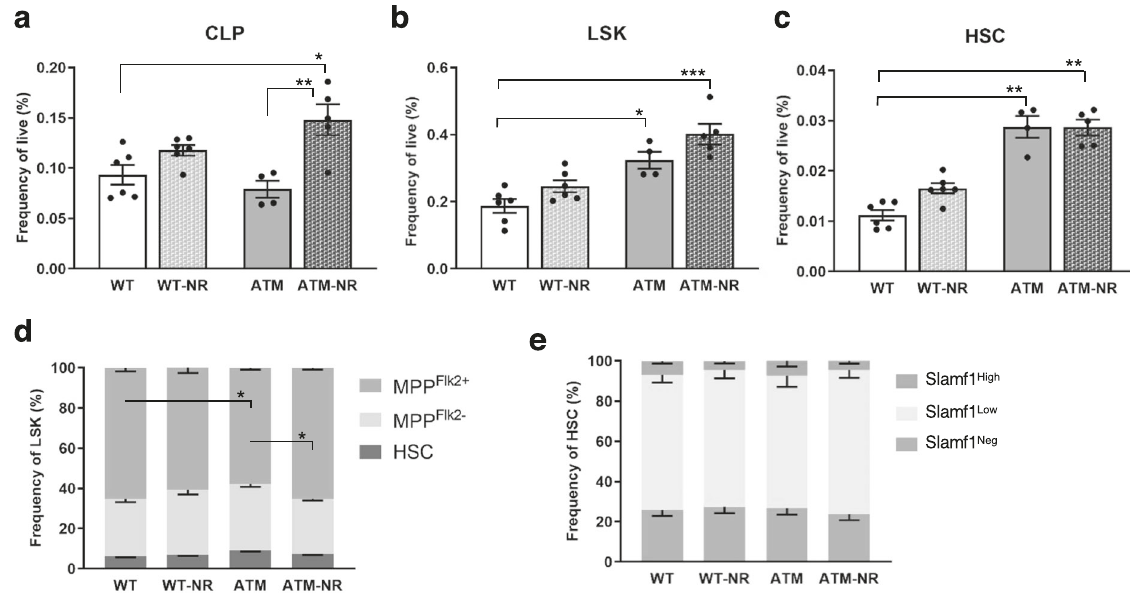
Fig. 1 NR treatment increases lymphoid-progenitor cell frequencies in Atm − / − bone marrow. a – c Frequency analysis of early progenitor compartments in NR-treated (NR) or untreated bone marrow from Atm + / + (WT) or Atm − / − (ATM) mice (2 – 3 months). CLP common lymphoid progenitors (Lin − IL-7R α + Flk2 + ), LSK lineage − Sca1 + c-Kit + , HSC Lin − c-Kit + Sca1 − CD34 − Flk2 − . d Composition of the LSK compartment. e Frequencies of lineage-biased subsets of HSCs de fi ned by Slamf1(CD150) expression. Data are represented as mean ± SEM. n : 4 – 6. Kruskal – Wallis test for a – c , two-way ANOVA for d and e . q value (Kruskal – Wallis test) or p value (two-way ANOVA): <0.05*, <0.01**,